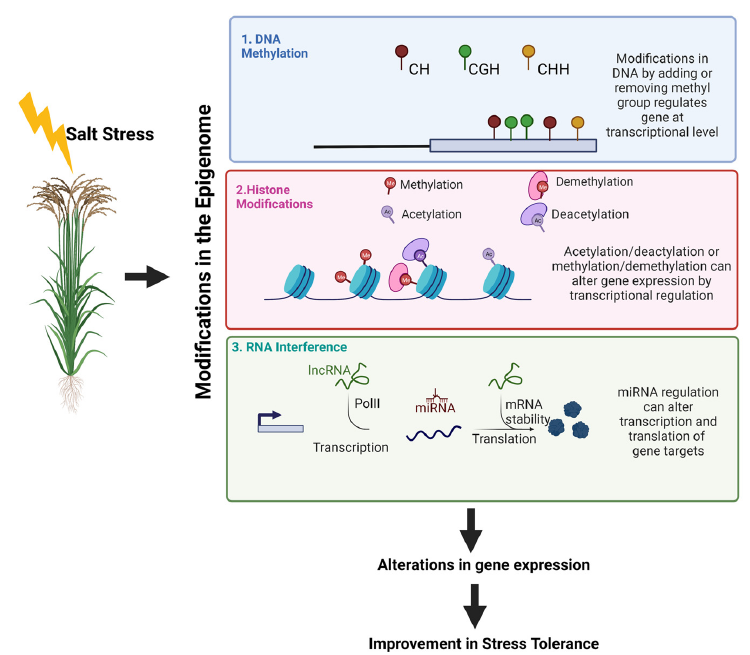
Figure 2. A summary of how epigenetics and salinity are related in terms to bring in modifications is given here. Modes of plant epigenetic modifications include (a) DNA methylation (b) alterations in histone modifications, and (c) RNA-directed DNA methylation. (a) Changes in DNA methylation is due to changes in the addition or removal of the methylated group, which in turn regulates at the transcriptional level. In plants, three types of methylation patterns are prevalent namely CG, CHH, and CHG. (b) Alterations in histone modifications bring about changes in the core histones of the nucleosomes and which occur through multiple reactions such as acetylation, deacetylation, and methylation, demethylation of a specific set of amino acids. (c) RNA-directed DNA methylation for these miRNAs arises from primary miRNA transcripts. DNA polymerase II transcribes them from miRNA genes. Within miRNA genes, pre-miRNAs present form a hairpin loop-like which later forms miRNA–miRNA* duplex structure. The miRNA* strand is degraded and the miRNA remains intact. This duplex upon transfer gets unwound, and then miRNA shuttles into RISC and this evenually binds to related target transcripts based on complementarities of the sequences affecting gene expression at the translational level. Image developed using Biorender.com (accessed on 7 September 2022).